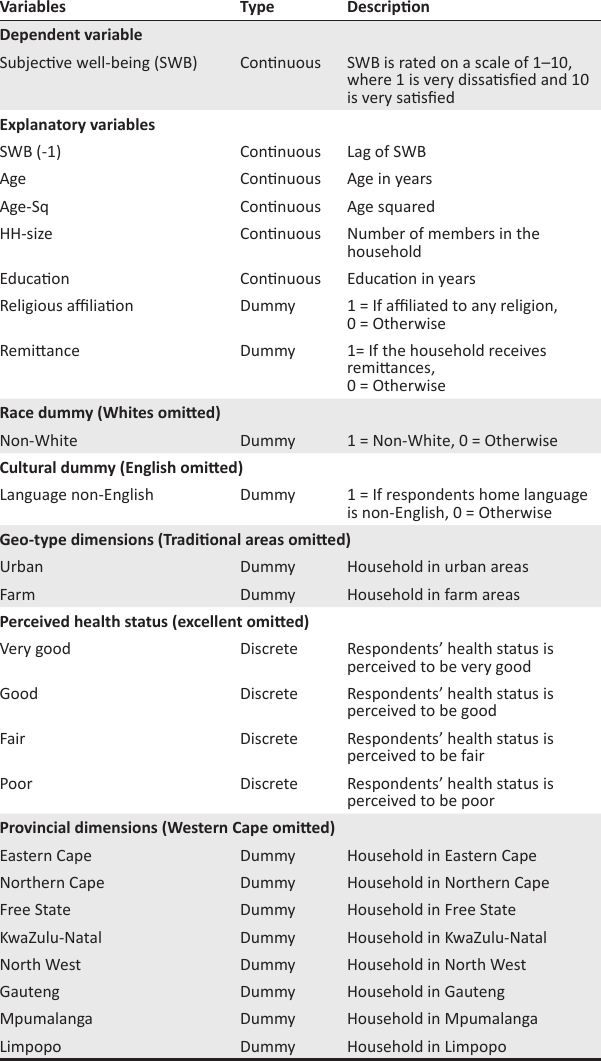
TABLE 1: Description of dependent and independent